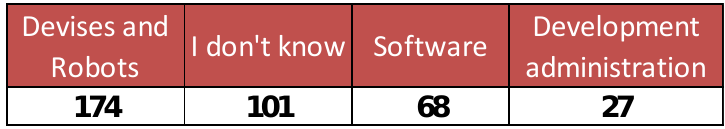
Table 4. Definition of CS in number of related answers